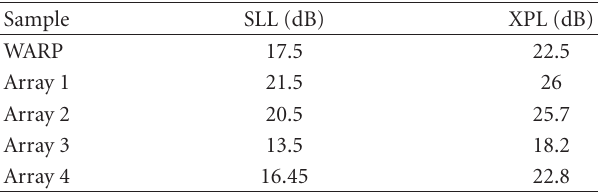
Table 1: Comparison of SLL and